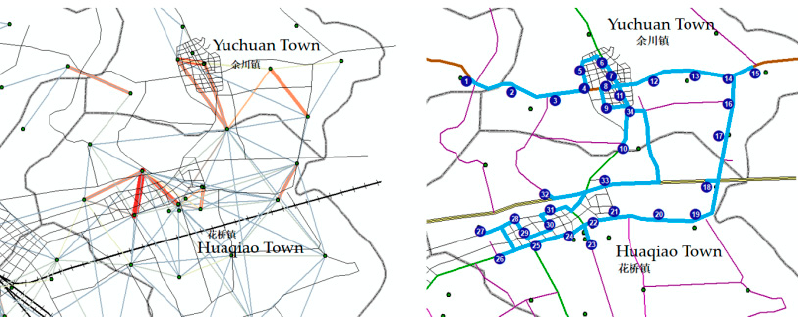
Figure 20. Travel OD distribution and bus route design in Huaqiao town and Yuchuan town.